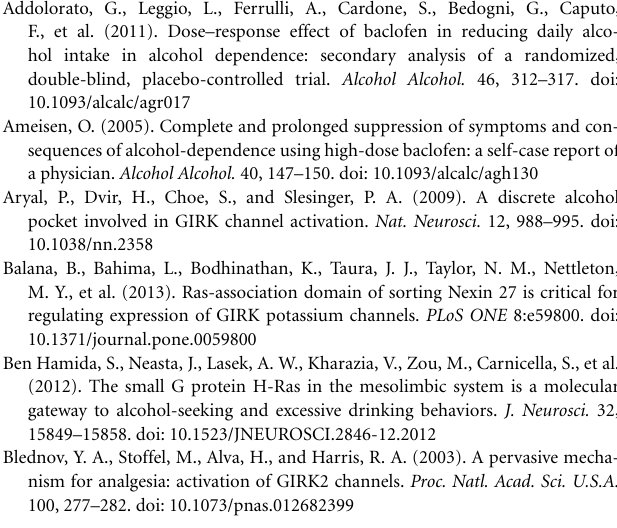
Supplemental Figure S1| Conservation of amino acids in alcohol pocket across species. Clustal Omega (EMBL-EBI) alignment of GIRK2 (Kir3.2/KCNJ6) sequences from different species reveals a high degree of conservation in the domains forming the alcohol pocket: N-terminal domain (pink), β D- β E loop (green) and β L- β M loop (blue). Leucine 257 (bold), which plays a critical role in alcohol activation, is conserved across multiple species. The respective NCBI sequence ID is also